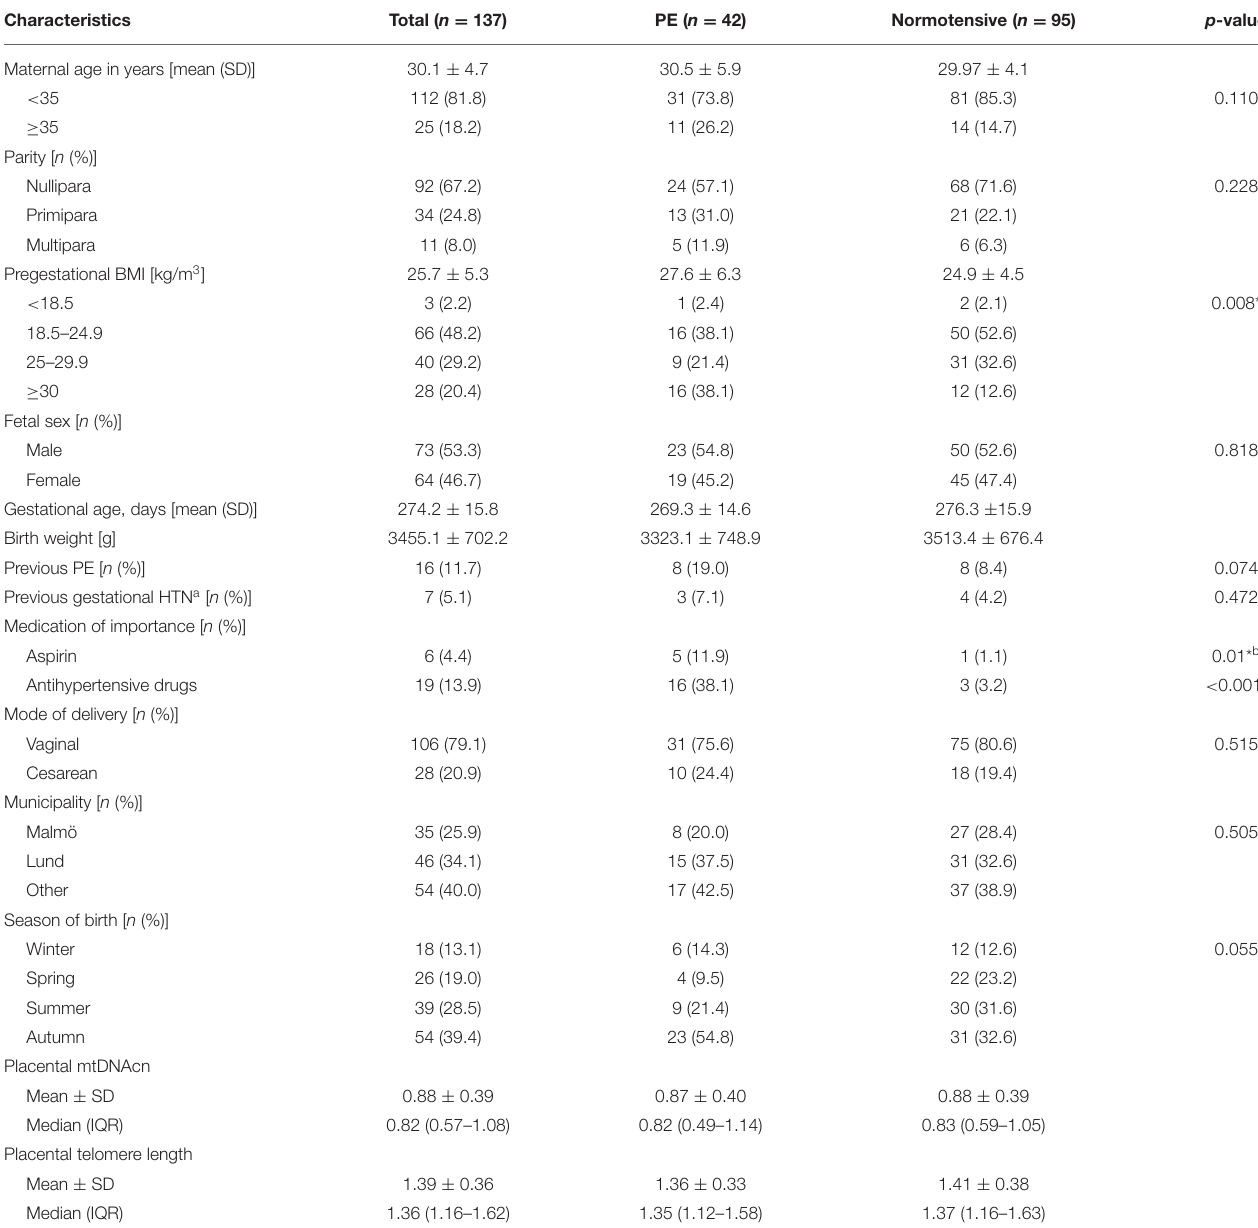
TABLE 1 | Characteristics of study participants stratified by preeclampsia status.